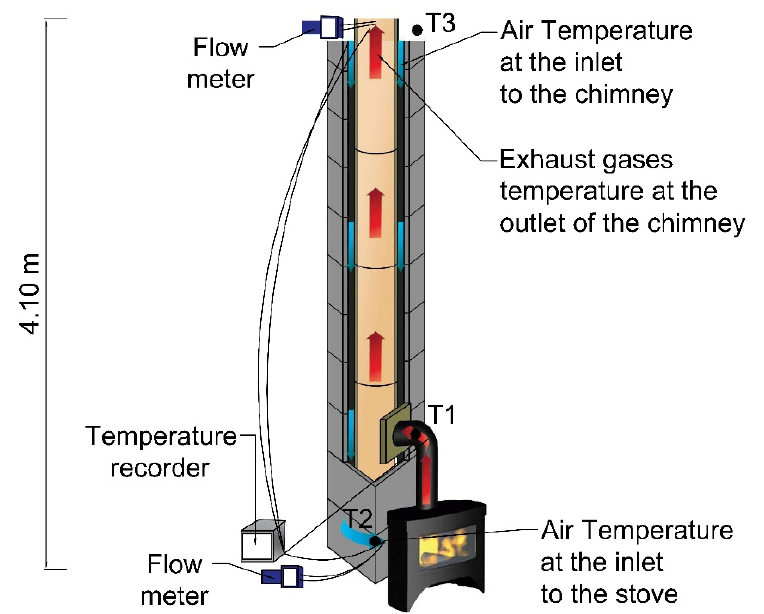
Figure 5. Test stand (blue and red arrows indicate air and exhaust, respectively).